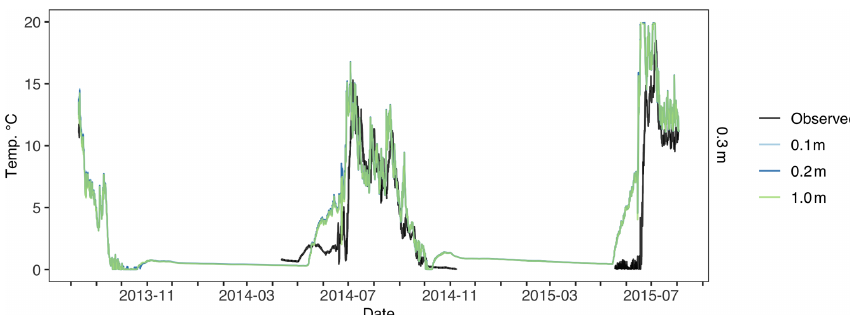
Figure E1. Atqasuk 0.3m water temperature across different soil vertical resolution simulations. Observed water temperature is in black, 0.1m vertical resolution is in light blue, 0.2m vertical resolution is in blue, and 1.0m vertical resolution is in